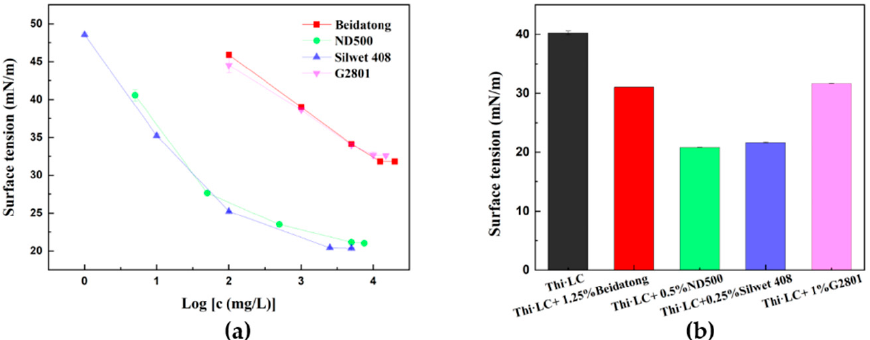
Figure 2. ( a ) Critical micelle concentration of four adjuvants. ( b ) The surface tension of Thi · LC without and with four adjuvants.